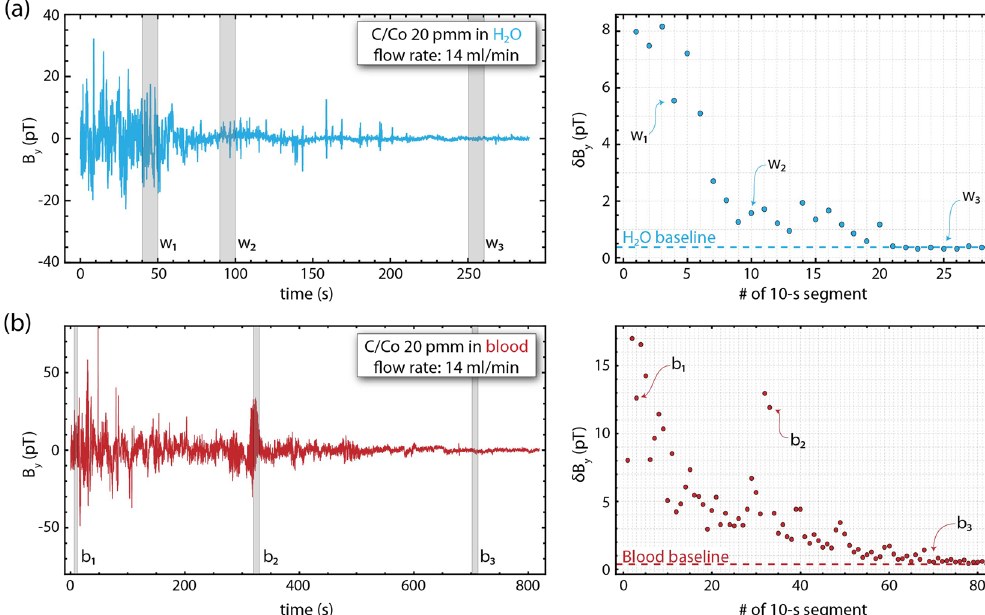
Figure 4. Real-time magnetic field measurements demonstrating nanoparticle magnetic separation for two different matrix media: ( a ) water (upper right and left plots); ( b ) blood (lower right and left plots). For the measurements we use 20 ppm C/Co:water/blood solutions. The large magnetic fluctuations observed during the separation measurements in blood [b2 in ( b )] are attributed to particle agglomeration (see supplementary